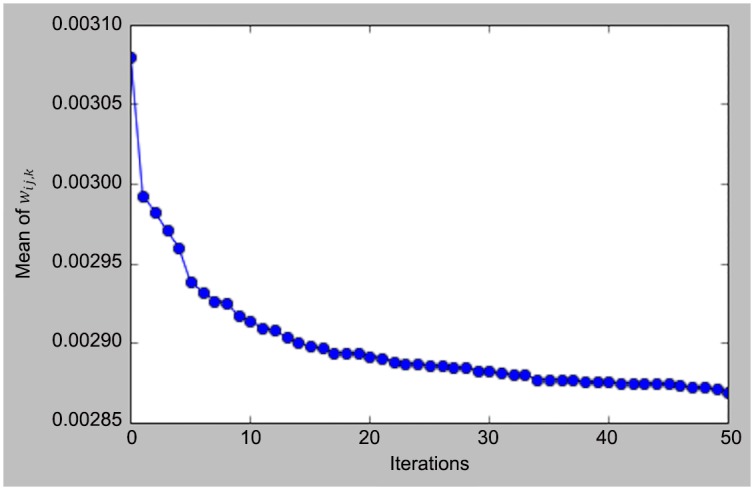
Convergence of mean of Σi,j,kwij,k.